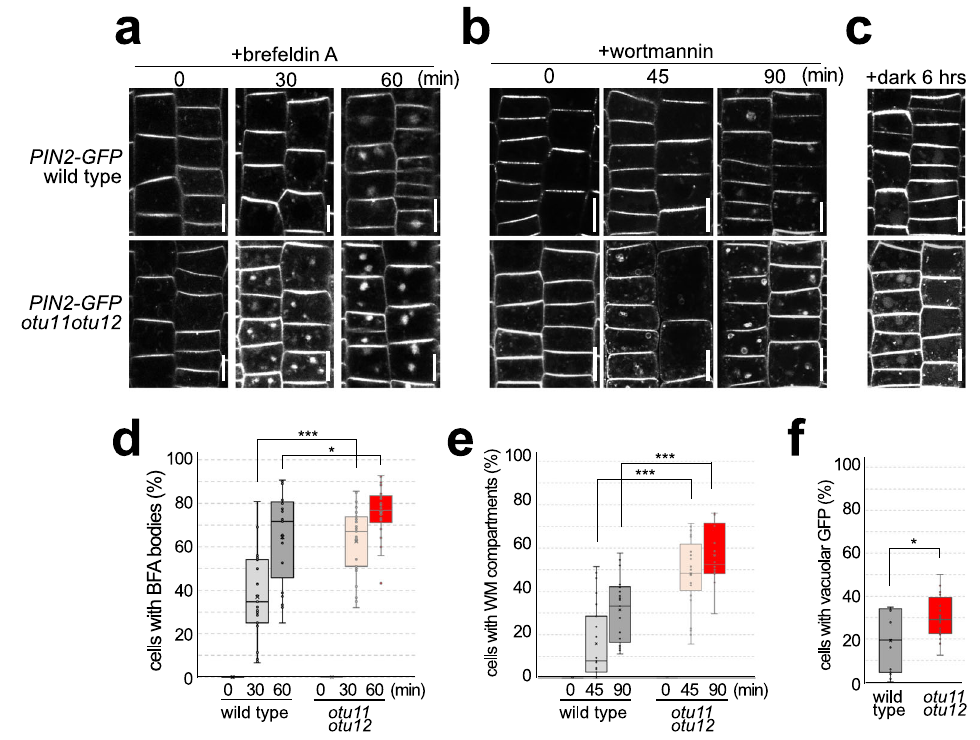
Fig. 5 | OTU11 and OTU12 affect the endosomal transport of PIN2-GFP. a – c Representative confocal images of epidermis cells of 7-day-old PIN2pro:PIN2- GFP expressingwild-typeor otu11otu12 seedlingstreatedwith50 µ MBFA( a ),33 µ M Wortmannin ( b ), or in the dark ( c ) for the indicated time. Scale bars: 10 µ m. d Quanti fi cationoftheBFAtreatmentin( a ).Theexperimentwasconductedtwice. For each seedling, cells with BFA bodies were counted and the percentage of cells with BFA bodies is shown as a box plot [wild-type 0min (4 seedlings, 126 cells), wild-type30min(23seedlings,795cells),wild-type60min(21seedlings,897cells), otu11otu12 0min (4 seedlings, 130 cells), otu11otu12 30min (31 seedlings, 1312 cells), otu11otu12 60min (22 seedlings, 877 cells)]. Center line, median; box limits, fi rstandthirdquartiles;whiskers,1.5xinterquartilerange;points,outliers. P values: